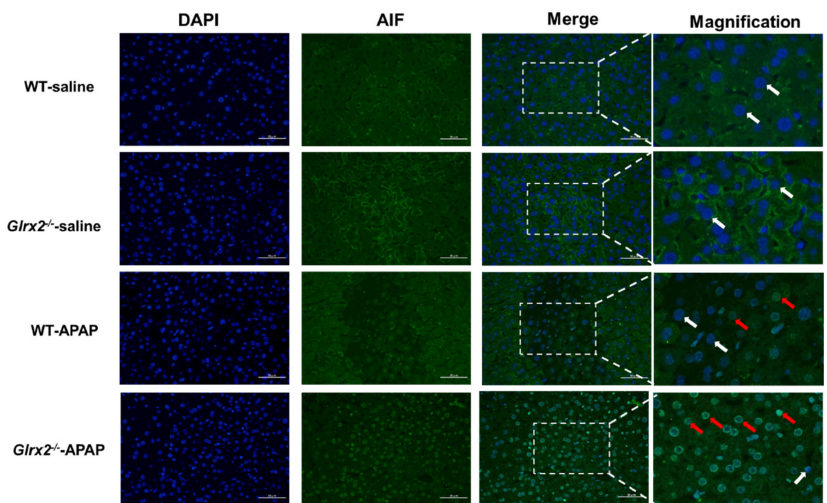
Figure 5. Glrx2 knockout enhanced nuclear translocation of AIF in livers from the mice treated with APAP. The nuclear translocation of AIF in liver tissue from mice at 6 h with or without treatment with 300 mg · kg − 1 APAP was detected by immunofluorescence. In both types of mice with saline treatment, the nuclei of DAPI appeared blue (indicated by white arrows). After APAP insult, AIF accumulated in nuclei, as shown by the merged colors (indicated by red arrows). Moreover, both the fluorescence intensity and number of nuclei with AIF increased in Glrx2 -deficient mice-Bars, 50 µ